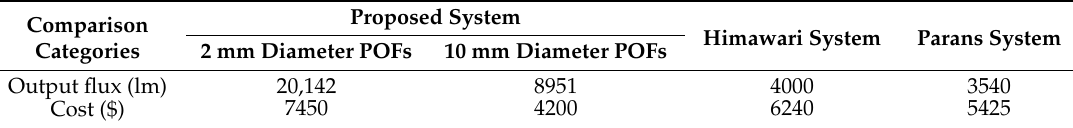
Table 4. Comparison in cost and daylight collection capability with some commercialized optical fiber daylighting systems.